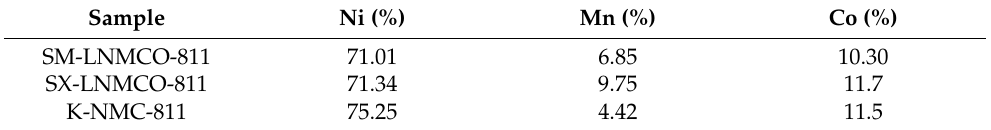
Table 5. Elemental compositions of Ni, Mn, and Co of the synthesized precursors (SM-LNMCO-811 and SX-LNMCO-811) and the commercial precursor (K-NMC-811) determined by XRF.